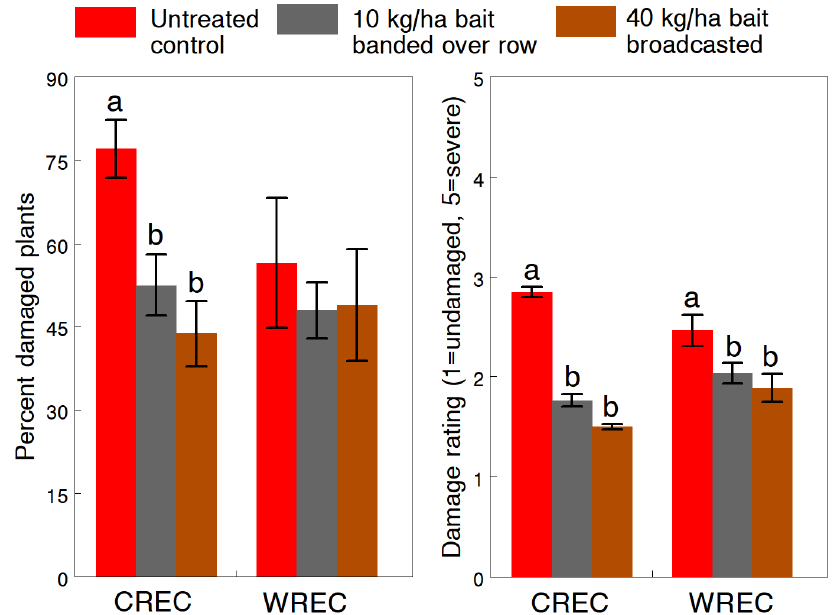
Figure 4. Effects of banded and broadcast applications of pelleted 4% metaldehyde bait (Deadline Bullet, AMVAC Chemical Corp., Los Angeles, CA, USA) on the percentage and severity of plant damage of the gray garden slug, Deroceras reticulatum . Means (±SEM) are presented for studies conducted at two University of Maryland research farms in 1993. Pairs of means within each study with different letters are significantly different at the 5% probability level.